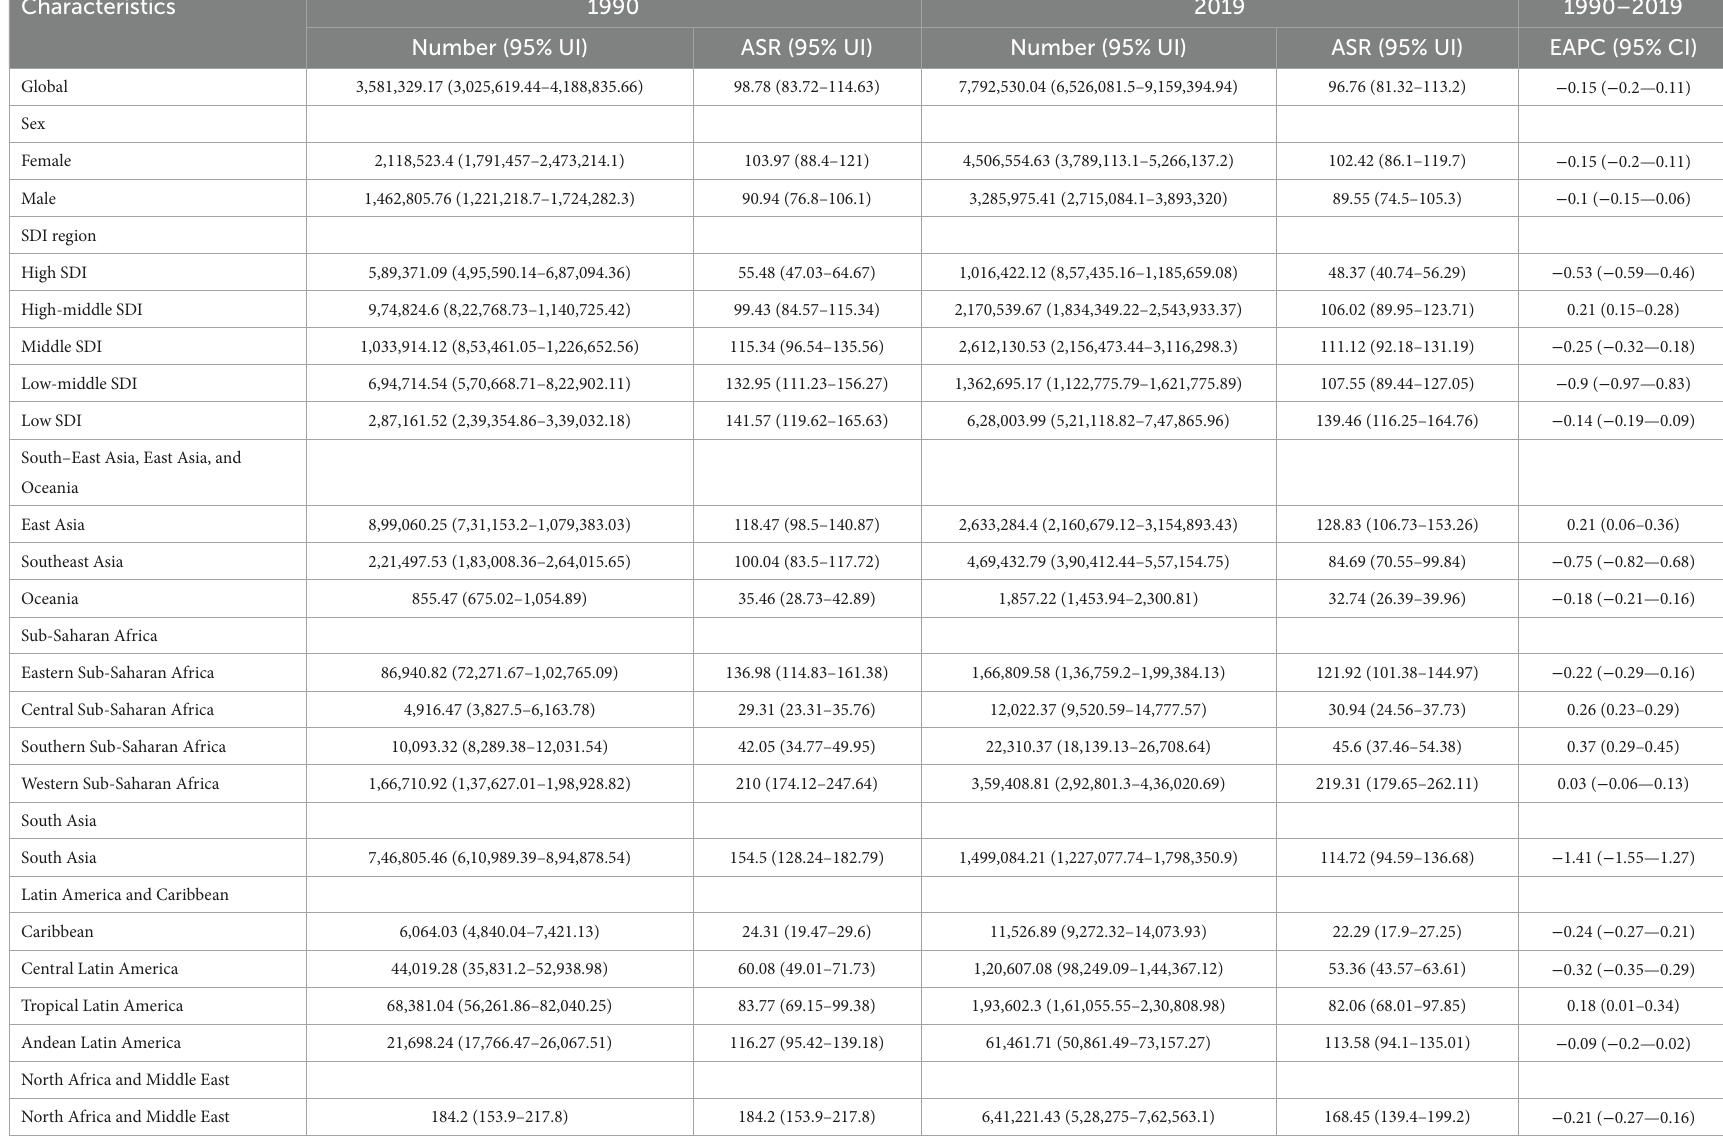
TABLE 1 Estimated number and age-standardized rate (per 100,000 persons) of prevalence and temporal trends for AMD from 1990 to 2019 by sex, SDI, and GBD regions.